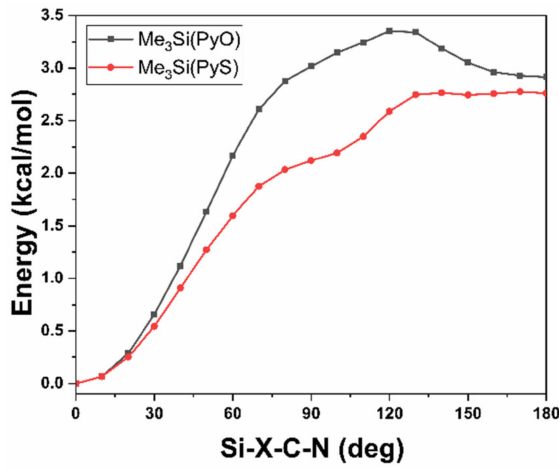
Figure 3. Relative energy graphs of the potential energy surface (PES) scan for torsion about the O-C and S-C bond in 1a and 1b ,